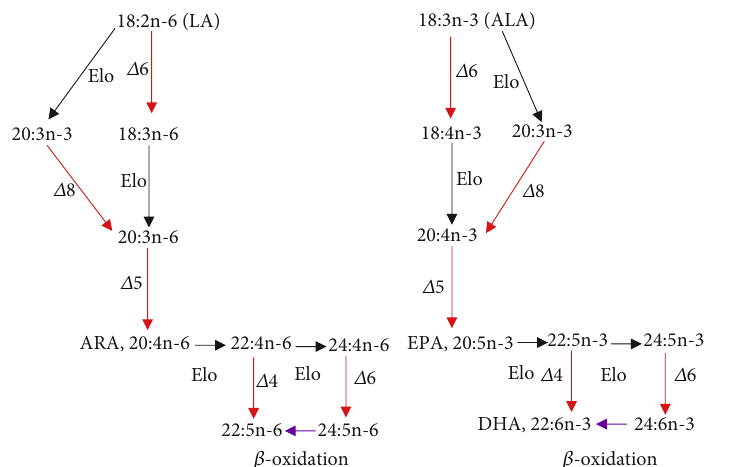
Figure 2: LC-PUFA pathways from the C18 precursors LA, C18: 2n-6 and LNA, C18:3n-3. Red arrows represent fatty acid desaturase while black arrows represent fatty acid elongase. Purple lines represent steps that have not been directly demonstrated in fi sh. Δ 8, Δ 6, Δ 5, and Δ 4: fatty acid desaturases; Elo: fatty acid elongases; short: peroxisomal chain shortening [28].